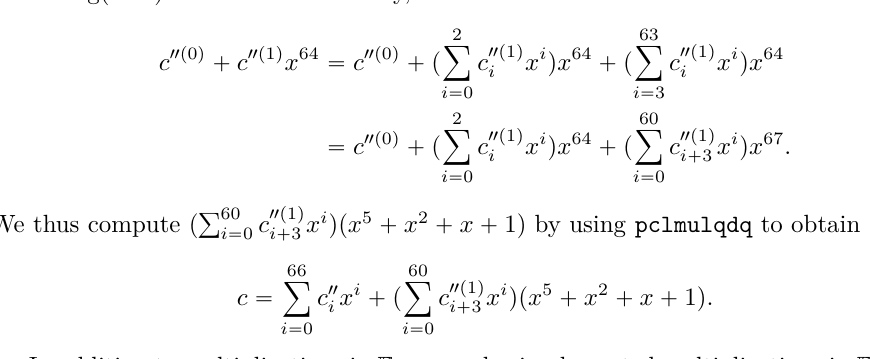
Figure 3: Our multiplication function for F